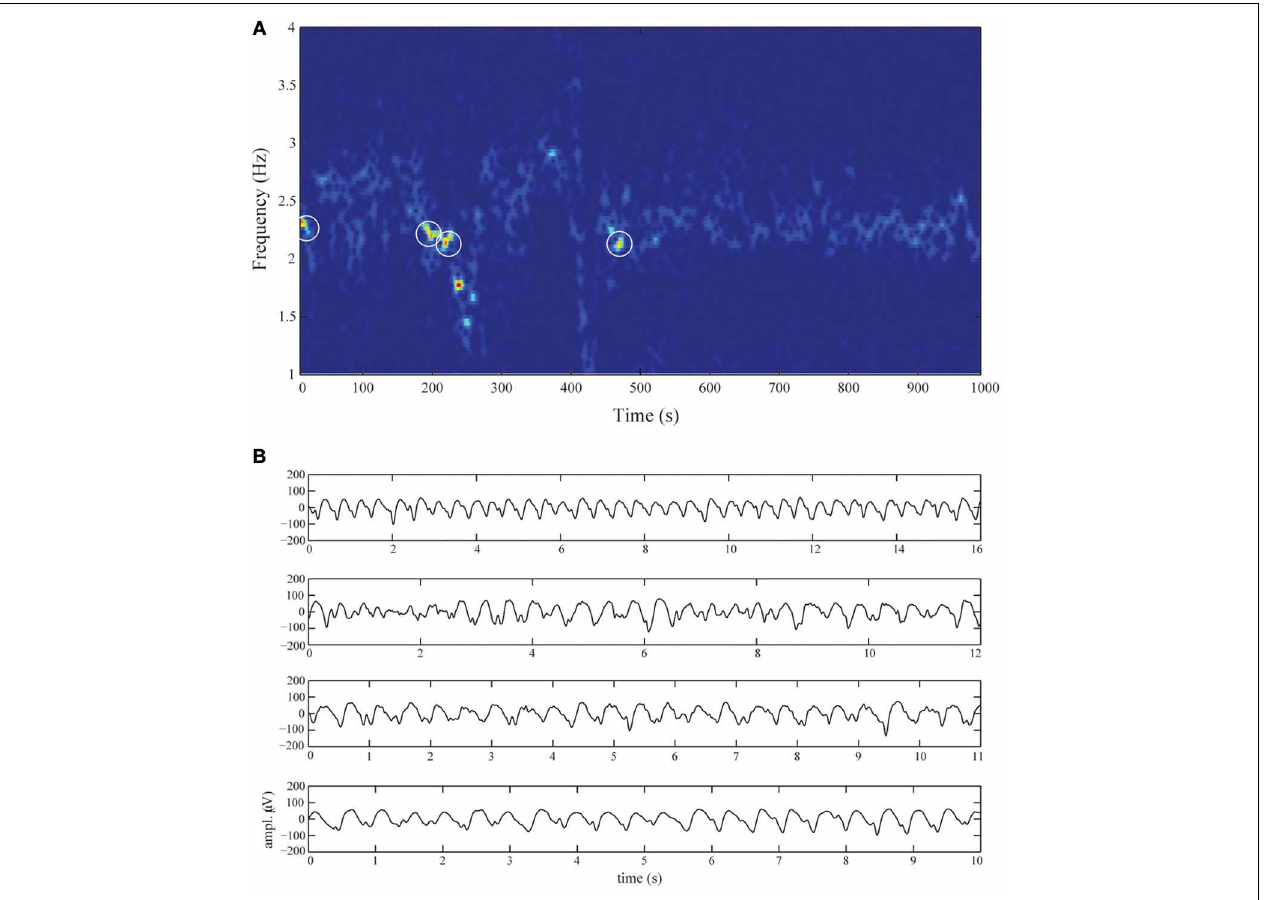
FIGURE 2 | Diffuse rhythmic delta activity during non-convulsive status epilepticus. (A) Spectrogram of electrode Fz over the entire recording-length. The activity is almost completely confined to frequencies in the delta band (1–3Hz). The four white circles